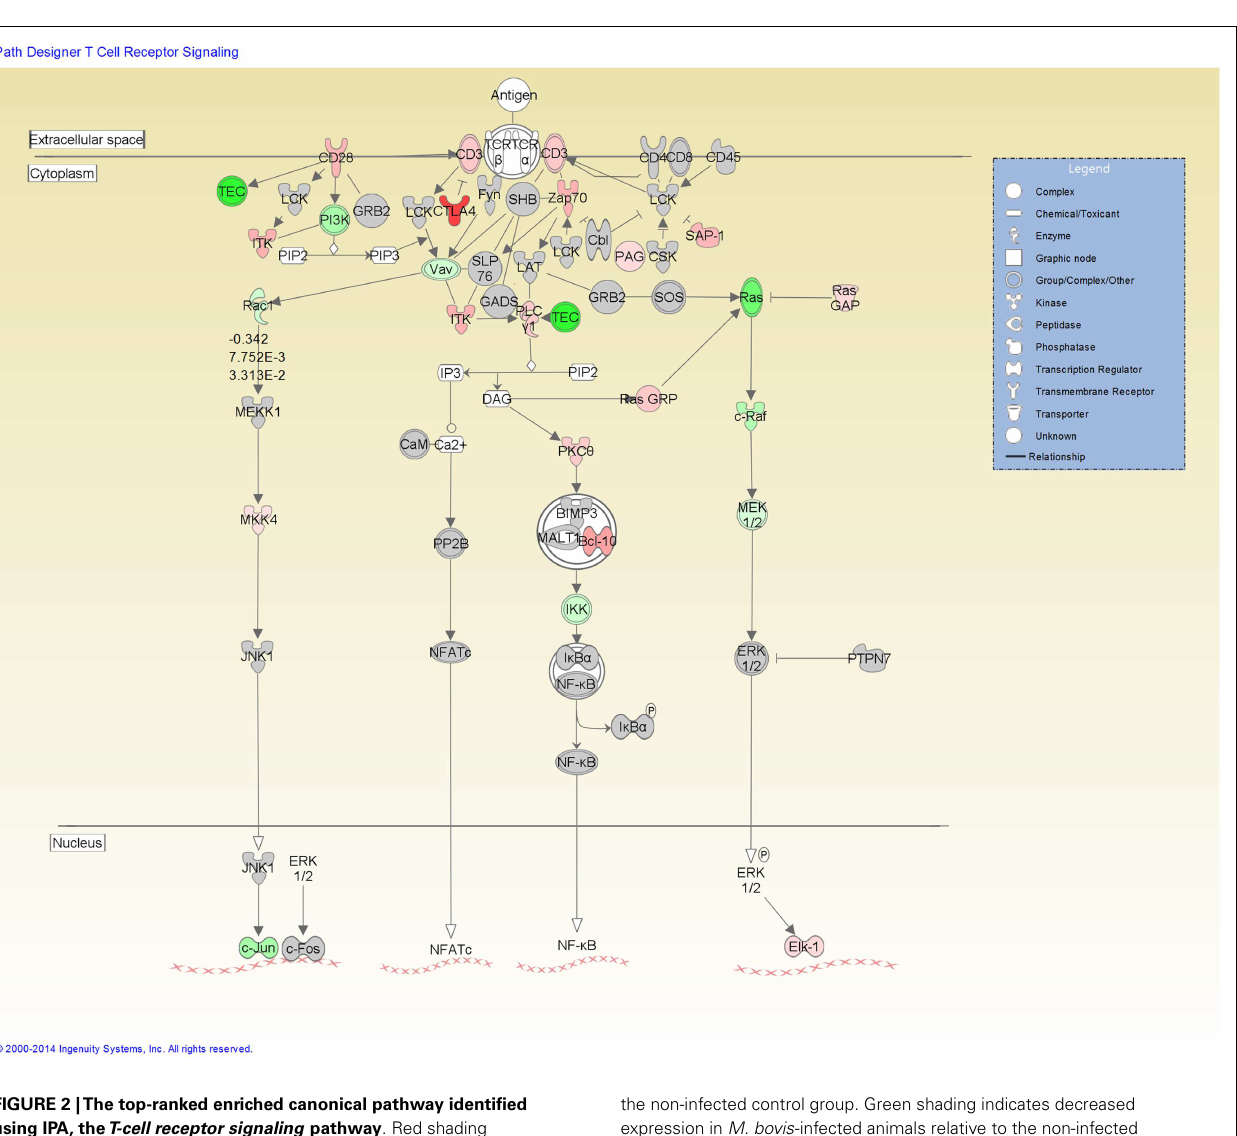
FIGURE 2 |The top-ranked enriched canonical pathway identified using IPA, the T-cell receptor signaling pathway . Red shading indicates increased expression in M. bovis -infected animals relative to